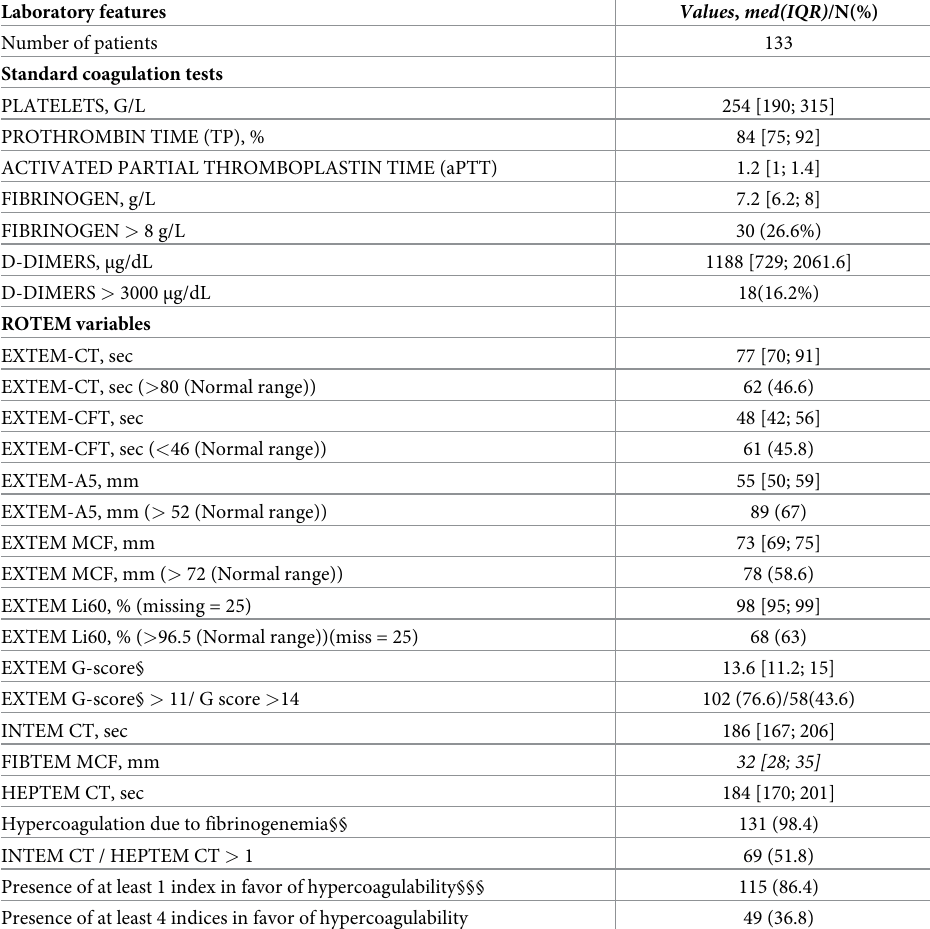
Table 2. ROTEM, blood count and standard hemostasis on admission. Laboratory